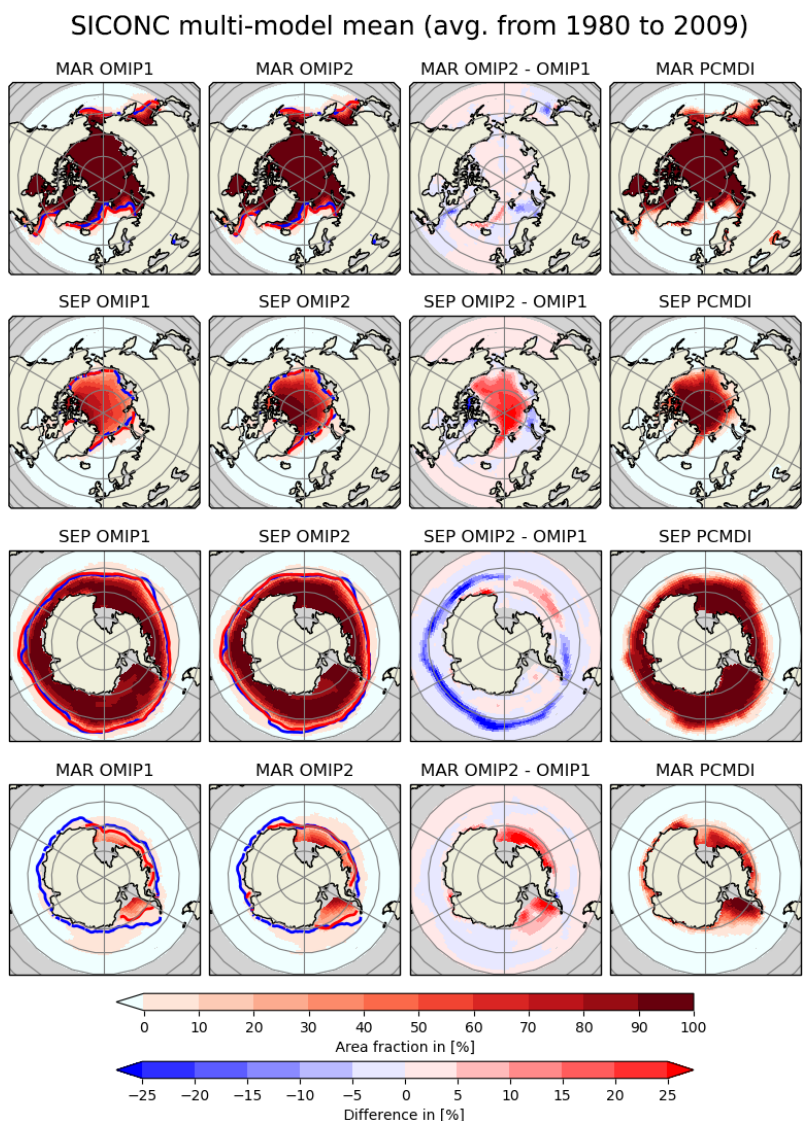
Figure 9. Multi-model mean 30-year (1980–2009) mean sea-ice concentration (%). Columns are (from the left) OMIP-1, OMIP-2, OMIP- 2 − OMIP-1, and an observational dataset provided by PCMDI-SST. Rows are (from the top) March and September in the Northern Hemi- sphere, and September and March in the Southern Hemisphere. Blue lines are contours of 15% concentration of the PCMDI-SST dataset and red lines are those of multi-model mean. See Figs. S16–S23 for results of individual